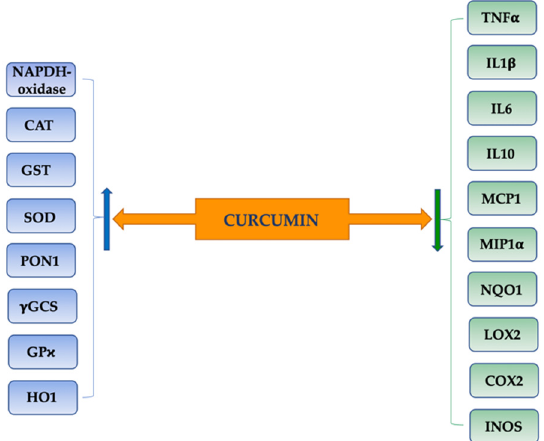
Figure 1. Molecular anti-inflammatory and antioxidant effects of curcumin. NAPDH: nicotinamide adenine dinucleotide phosphate; CAT: catalase; GST: glutathione S-transferase; SOD: superoxide dismuthase; PON1: paraoxonase-1; γ GCS: γ -glutamylcysteine synthetase; GP χ : glutathione peroxidase- χ ; HO1: heme oxygenase-1; TNF α : tumor necrosis factor- α ; IL1 β : interleukin-1 β ; IL6: interleukin-6; IL10: interleukin-10; MCP1: monocyte chemoattractant protein-1; MIP1 α : macrophage inflammatory protein 1 α ; NQO1: quinone oxidoreductase-1; LOX2: lipoxygenase-2; COX2: cyclooxygenase-2; INOS: nitric oxide synthase.